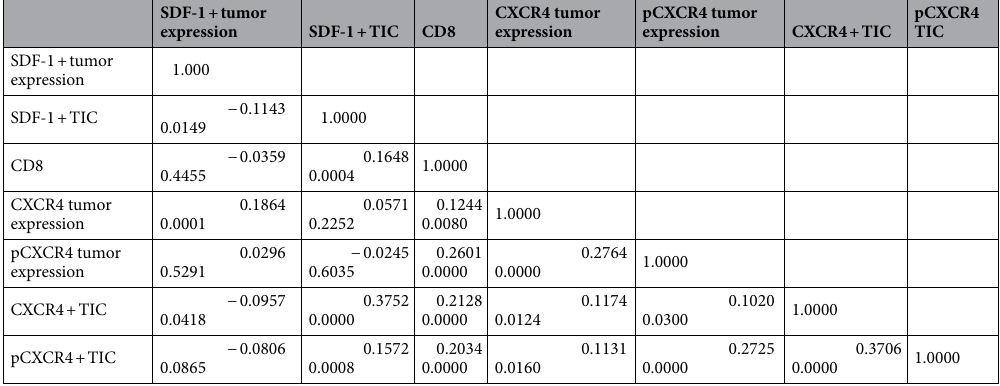
Table 3. Spearman’s correlation analysis of SDF-1 protein expression with CXCR4, pCXCR4 and CD8.